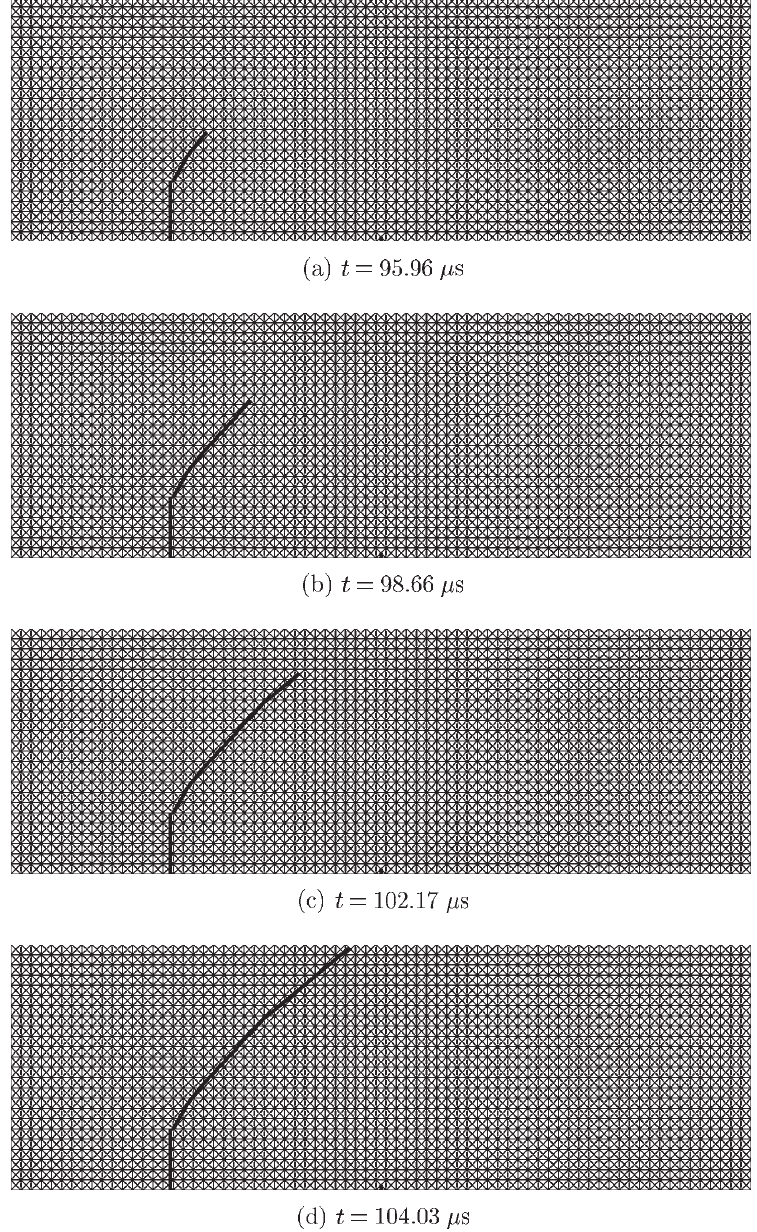
Fig. 8. Crack evolution for 73 × 24 cross-triangular mesh with γ =